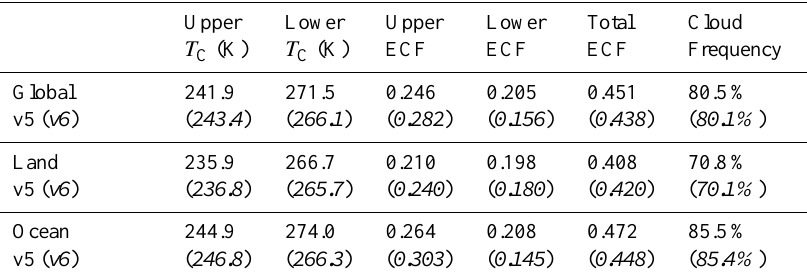
Table 1. Mean v5 ( v6 ) global (land and ocean only, and land + ocean) area-weighted cloud properties for January 2007. Cloud frequency is defined as an AIRS FOV that contains a value of ECF>0.01 (the sum of both cloud layers).